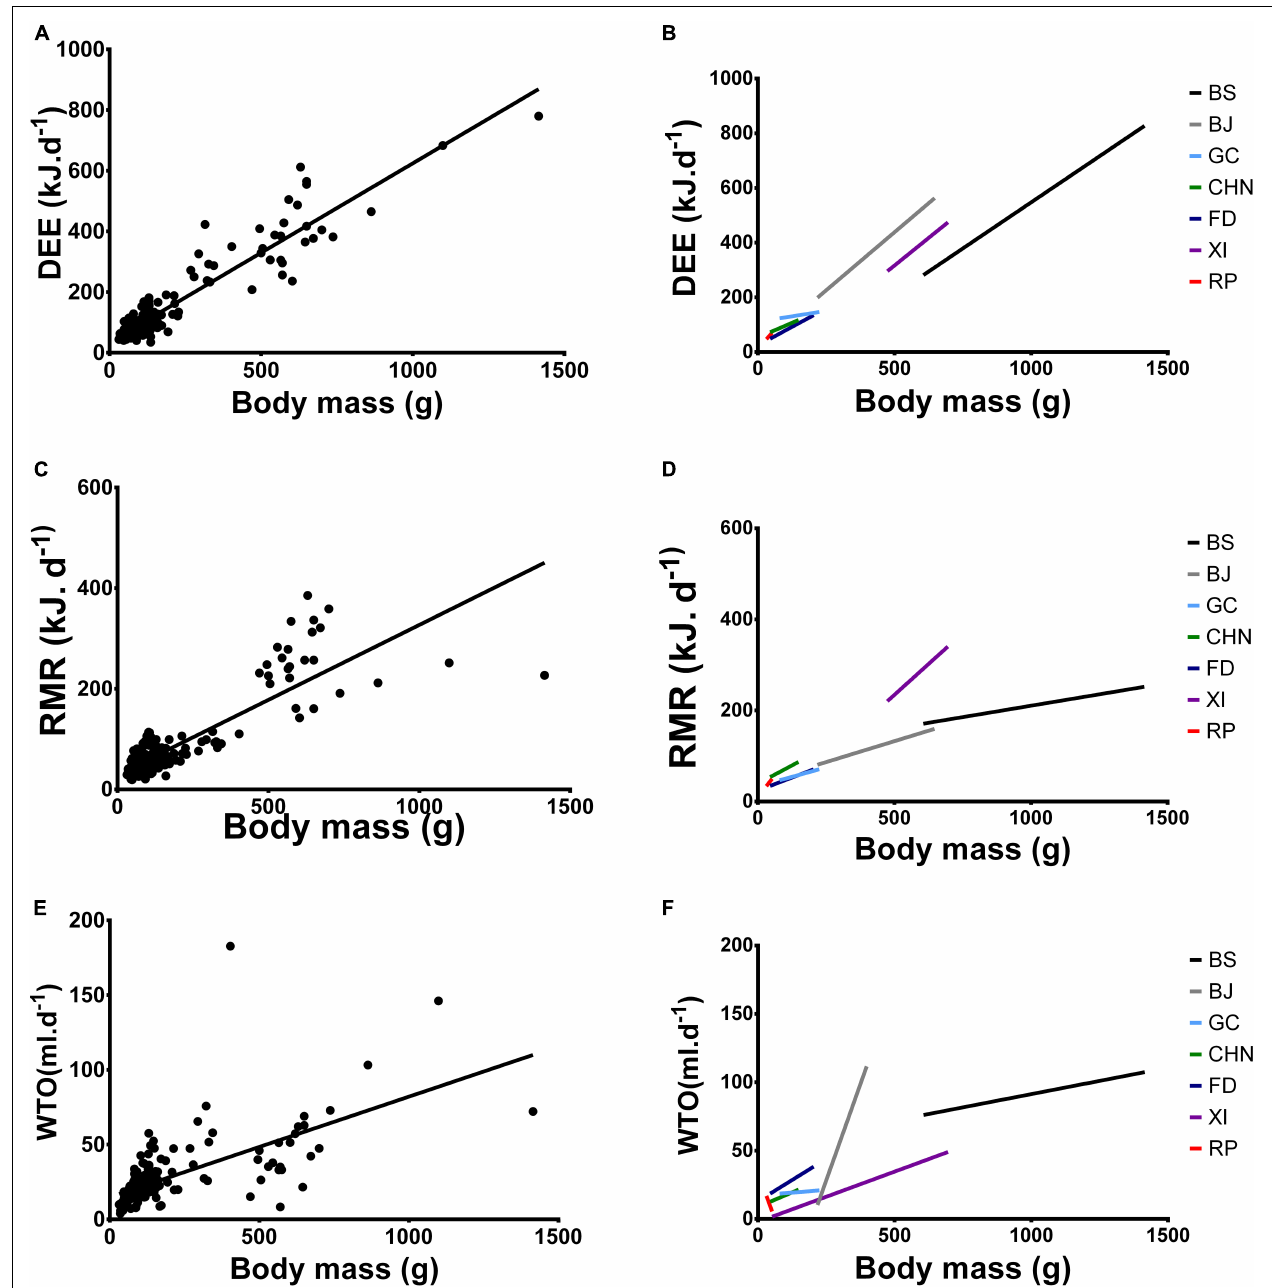
FIGURE 4 | Daily energy expenditure (DEE- kJ.d – 1 ) against body mass (g) of (A) all seven species of rodent combined and (B) all seven species of rodent separated. Resting metabolic rate (RMR- kJ.d – 1 ) against body mass (C) all seven species of rodent combined and (E) all seven species of rodent separated. Water turnover (WTO- ml.d – 1 ) against body mass (D) all seven species of rodent combined and (F) all seven species of rodent separated. BS - Bathyergus suillus; BJ: Bathyergus janetta ; GC - Georychus capensis ; CHN - Cryptomys hottentotus natalensis ; FD - Fukomys damarensis ; XI - Xerus inauris ; RP - Rhabdomys pumilio